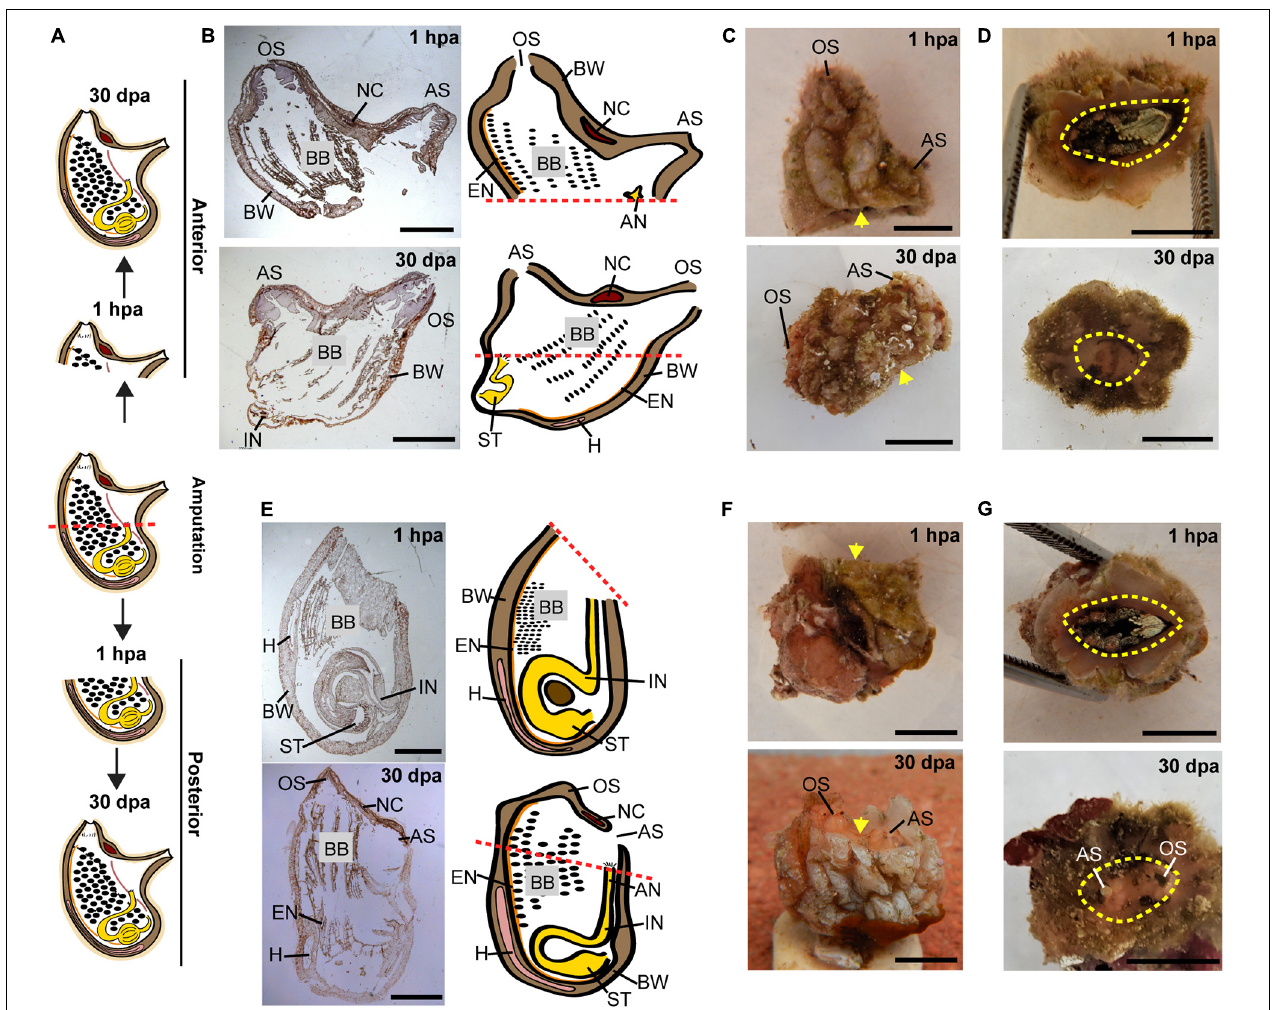
FIGURE 2 | Regeneration along the AP axis into two separate animals is complete by 30 dpa. (A) Illustration depicting the regeneration process at 1-h post amputation (hpa) and 30 dpa. (B–D) Regeneration of the posterior body part from the anterior fragment. (B) Section left view and matching illustration. Red dashed lines indicate amputation line. (C,D) In vivo images. (C) Left view. Yellow arrow indicates wound area. (D) Bottom view. Yellow dashed lines indicate wound border. (E–G) Regeneration of the anterior body part from the posterior fragment. (E) Section left view and matching illustration. (F,G) In vivo images. (F) Left view. (G) Top view. Anus (AN), atrial siphon (AS), body wall (BW), branchial basket (BB), endostyle (EN), heart (H), intestine (IN), neural complex (NC), oral siphon (OS), stomach (ST). Scale bar in (C,D,F,G) : 0.5 cm, and in: (B,E) : 3 mm (see also Supplementary Table 1 and Supplementary Figure 1